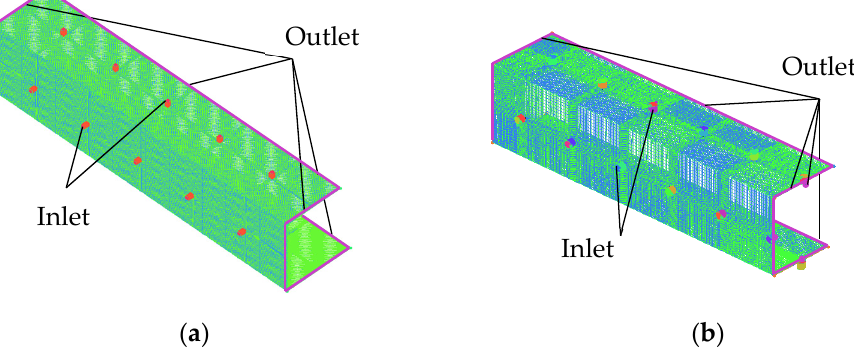
Figure 5. The CFD models with ( a ) balanced and ( b ) unbalanced air films.